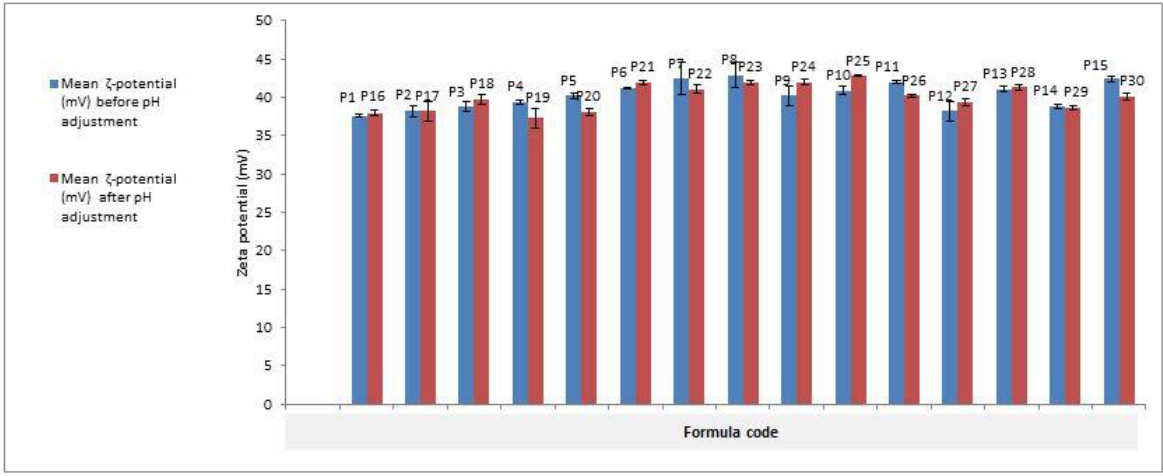
Fig. 3: Effect of pH change of chitosan and TPP solutions on the zeta potential of drug-free